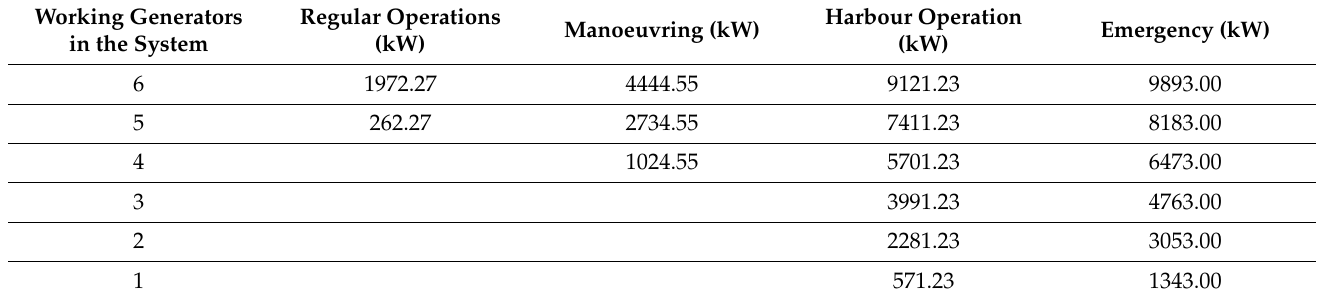
Table 2. Battery charging power